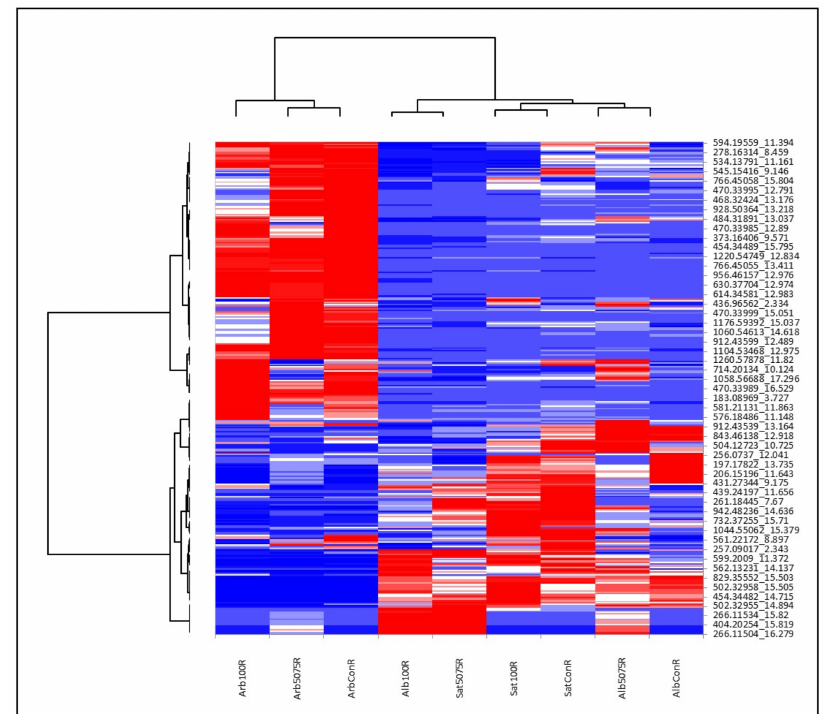
Figure 4. Heat map analysis of UHPLC-HRMS/MS metabolomics in roots. The row represents each metabolite and the column represents each treatment. Metabolites significantly decreased are displayed in red, while metabolites significantly increased are displayed in blue.